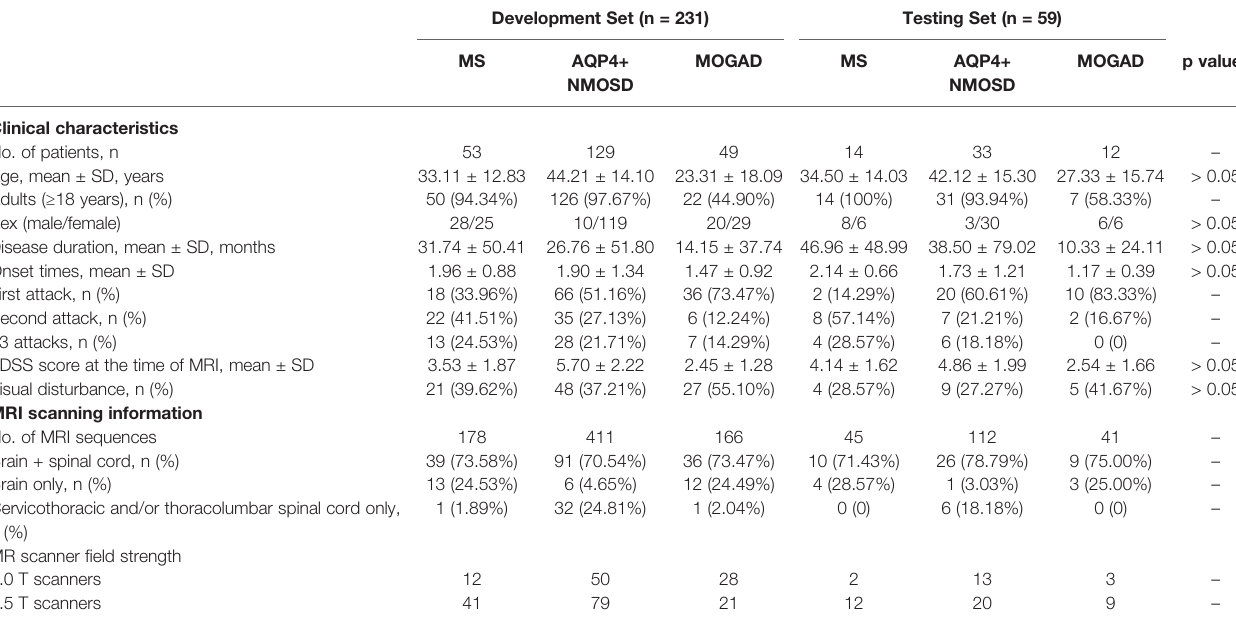
TABLE 1 | Demographic and clinical characteristics in patients with MS, AQP4+ NMOSD, and MOGAD.